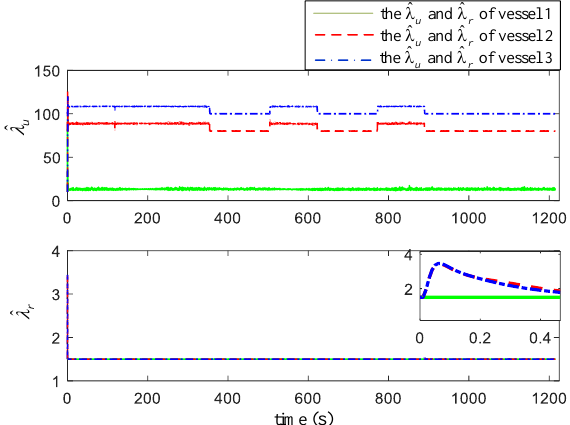
Figure 8. The changes in adaptive laws λ u and λ r during